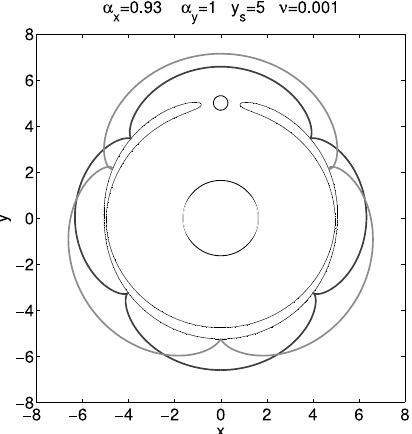
Fig. 7. Two stable symmetric periodic orbits with C = (cid:0) 0 . 30011 for the shape parameters α x = 0 . 93 and α y =